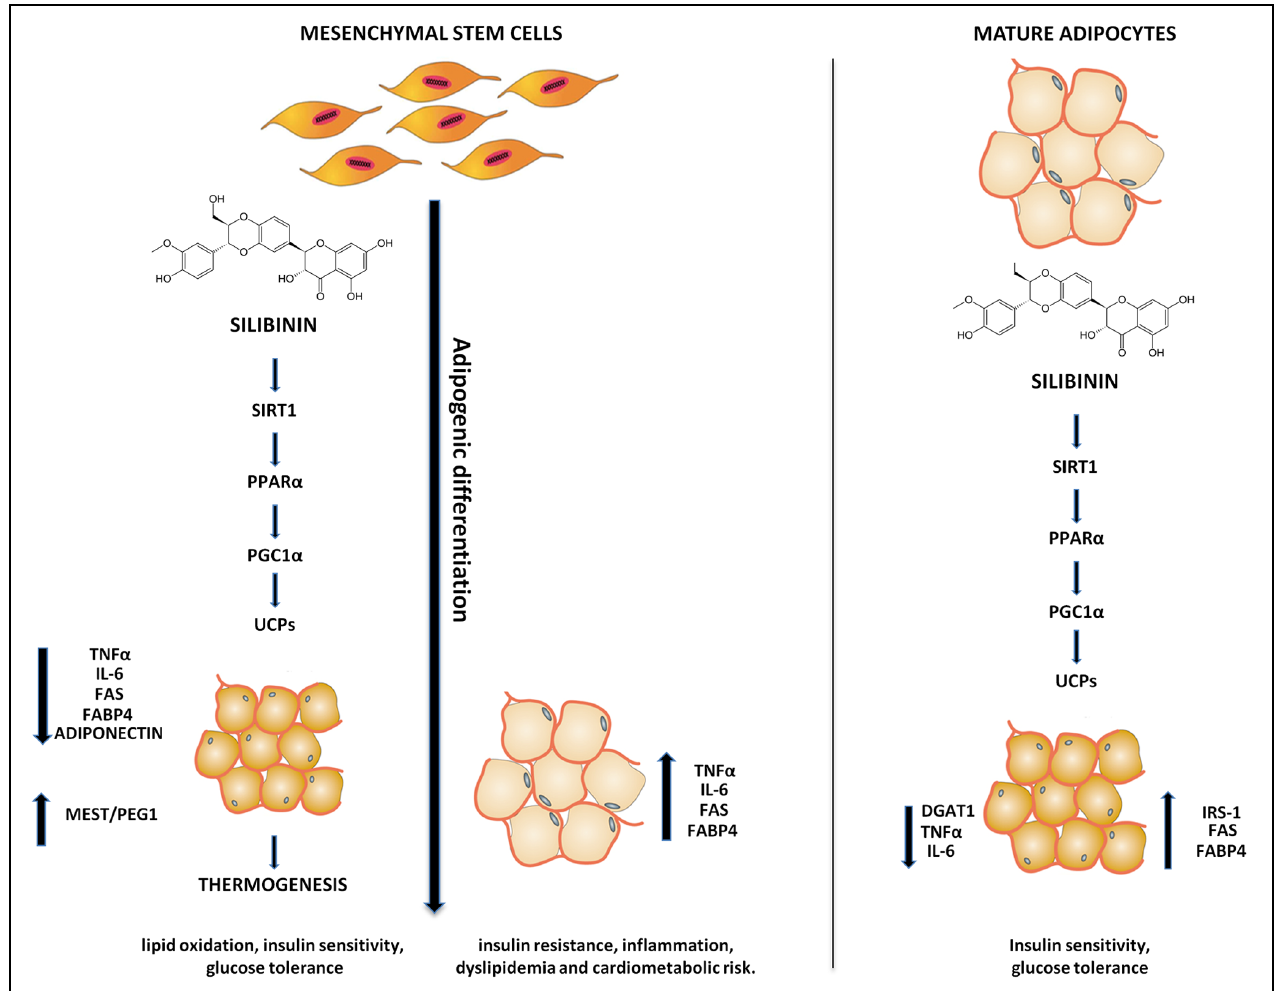
FIGURE 7 | Scheme of the silibinin effects during adipogenic differentiation and in mature adipocytes. Adipogenic differentiation causes an increase in TNF α , IL-6, FAS, FABP4, and MEST/PEG1 resulting in an increase of insulin resistance, inflammation, dyslipidemia, and cardiometabolic risk. Silibinin switches the lipid metabolism of adipocyte to thermogenic pathway resulting in an improvement of insulin sensitivity and glucose tolerance.